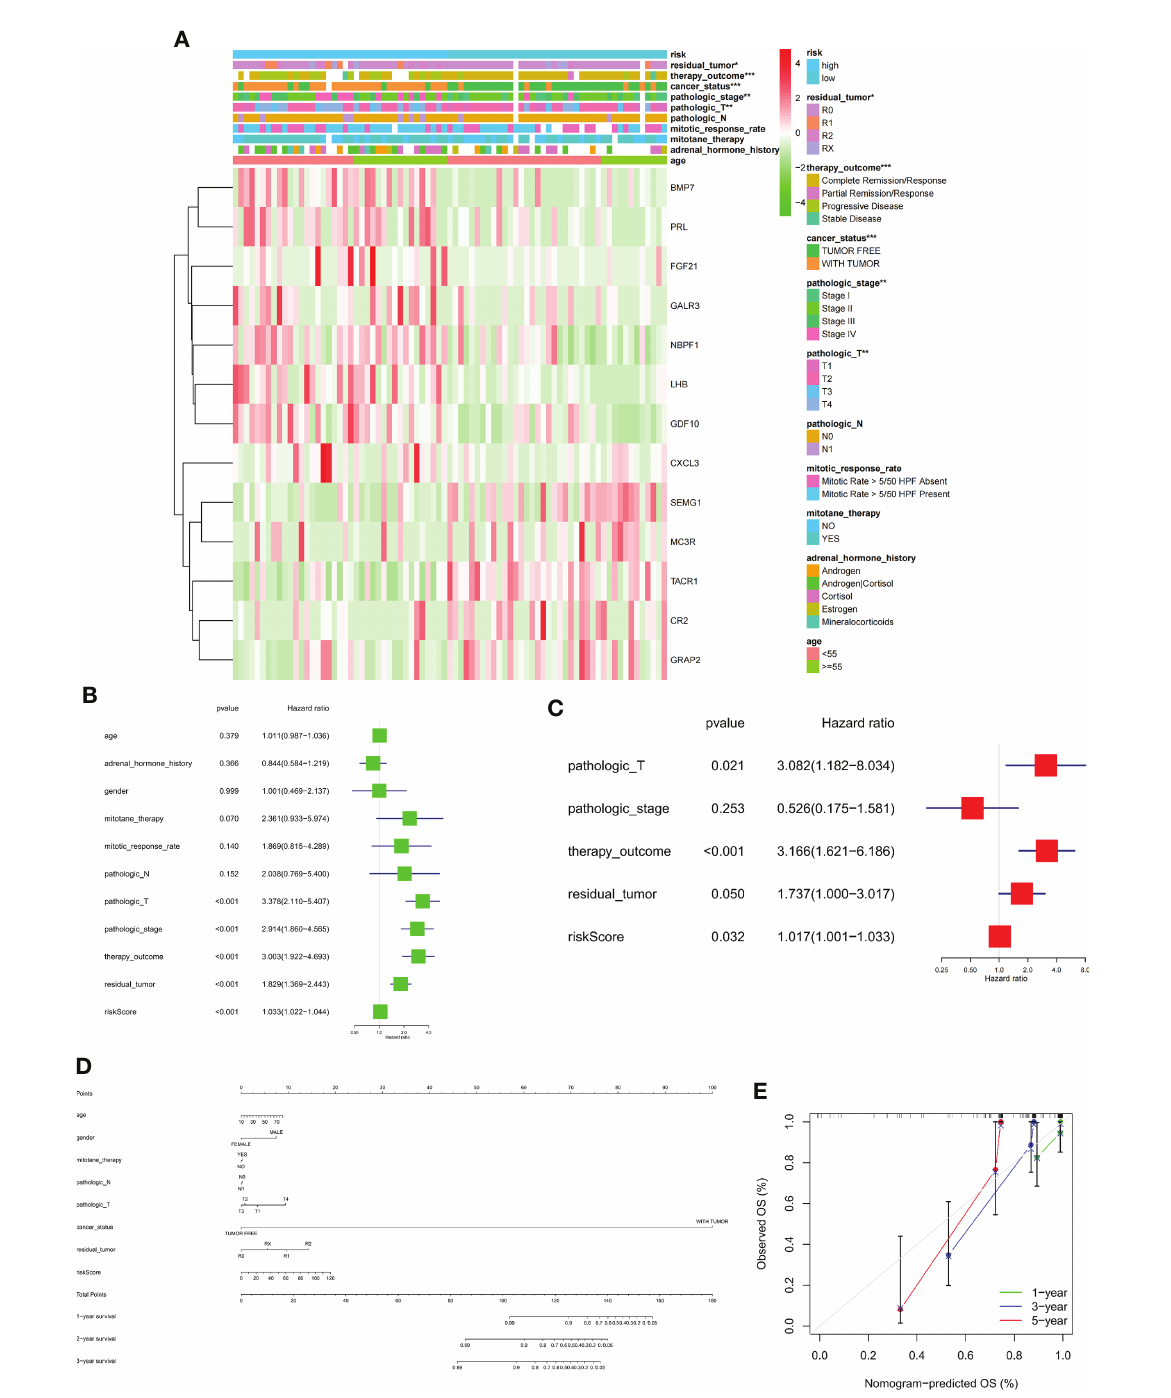
FIGURE 9 (A) Heatmap comparison of several clinical factors between low- and high-risk groups. (B, C) Univariate Cox regression (green) and multivariate Cox regression (red) showing that the risk signature is an independent prognostic factor for ACC patients. (D) Normogram and (E) calibration curve prediction of the probability of 1-,2-,3-years OS for ACC patients (*p < 0.05, **p < 0.01, ***p <